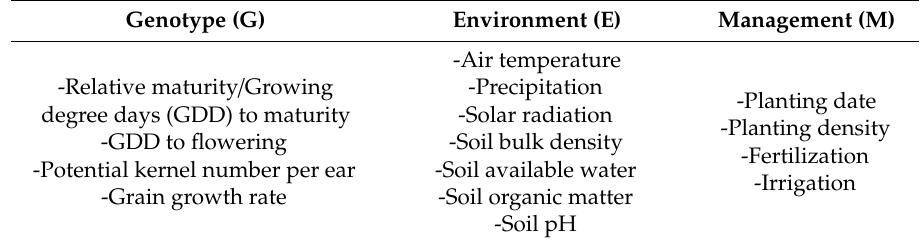
Table 1. Examples of common G × E × M factors included in crop growth model simulations